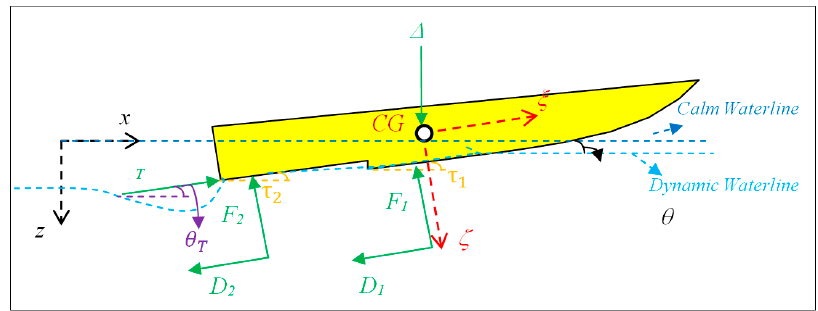
Figure 1. The problem definition and coordinate systems.